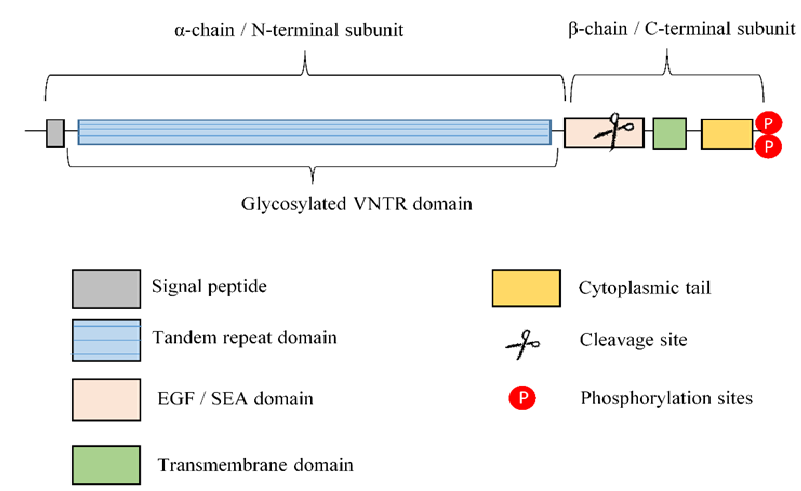
Figure 2. General structure of the transmembrane mucins. Transmembrane mucins are composed of two subunits: α chain or N-terminal subunit and β chain or C-terminal subunit, based on the putative proteolytic cleavage site in the epidermal growth factor / sperm protein, enterokinase and agrin (EGF / SEA) domain. The α -chain is extracellular and predominantly composed of variable number of tandem repeats (VNTR) highly glycosylated. The β -chain consists of a short extracellular region (containing either SEA domain or EGF-like domain), single transmembrane (TM) domain, and the cytoplasmic tail, which contains multiple phosphorylation sites.